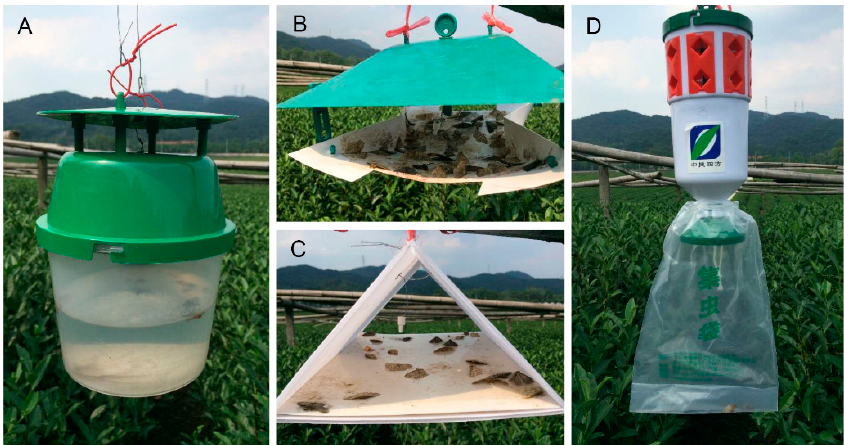
Figure 6. Four kinds of traps were tested in the field trapping. ( A ) bucket funnel trap; ( B ) sticky wing trap; ( C ) delta trap; ( D ) noctuid trap.